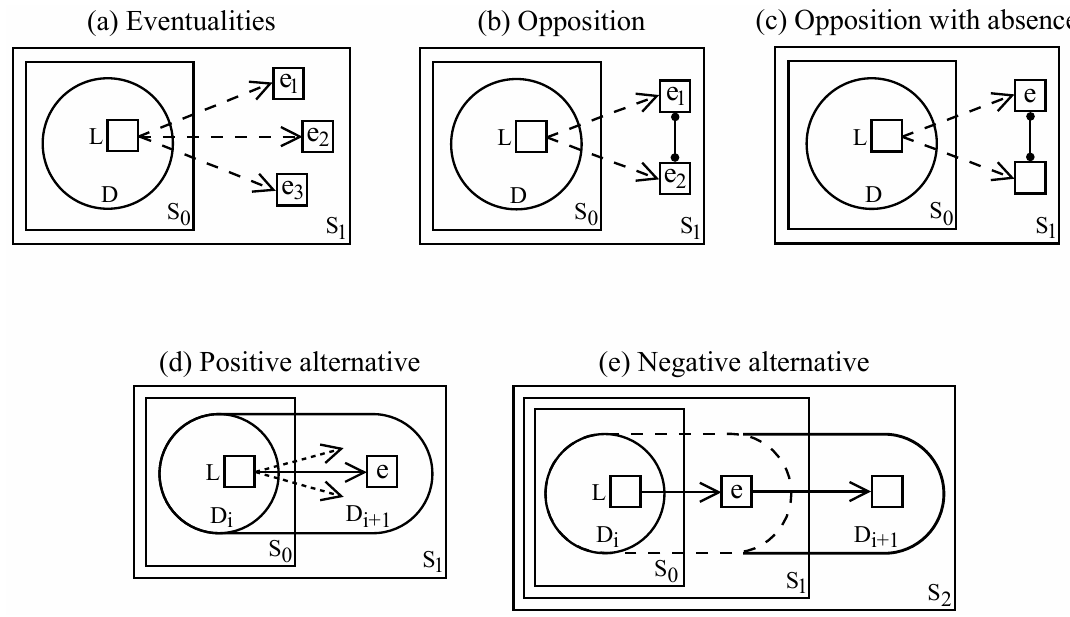
Figure 6. Negation as conceptual elaboration.